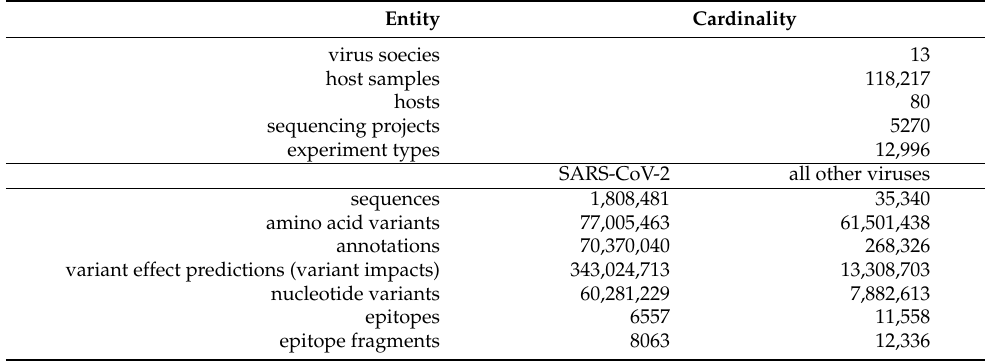
Table 1. Cardinalities of the tables (without the optimization data structures) included in the test